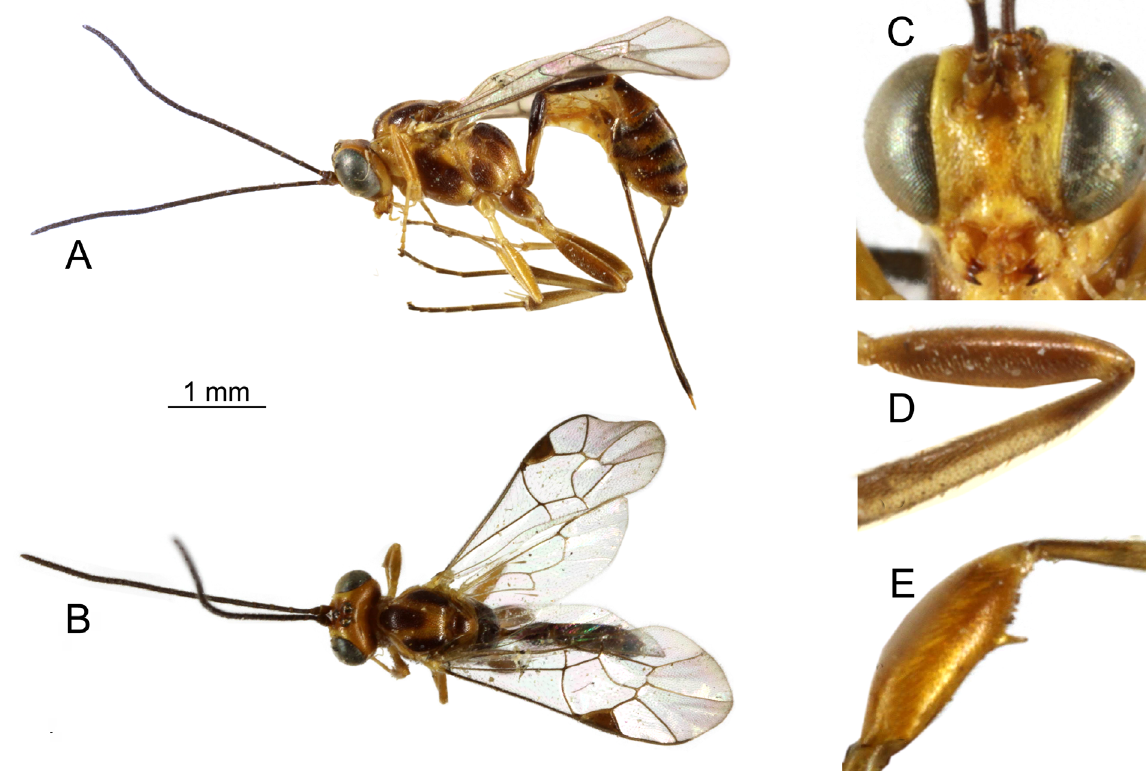
Fig. 11. Pristomerus moramora sp. nov. A . ♀, habitus, profile. B . ♀, habitus, dorsal. C . ♀, head, facial. D . ♀, hind femur,